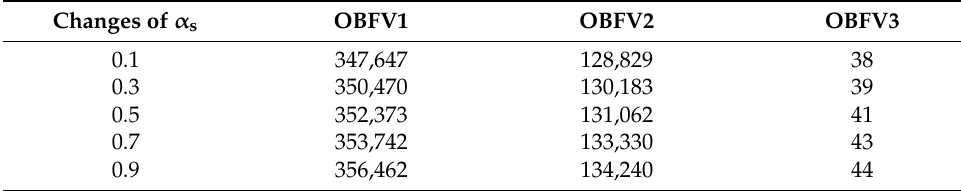
Table 9. OBFVs in changing effect of parameter 𝛼 𝑠 .